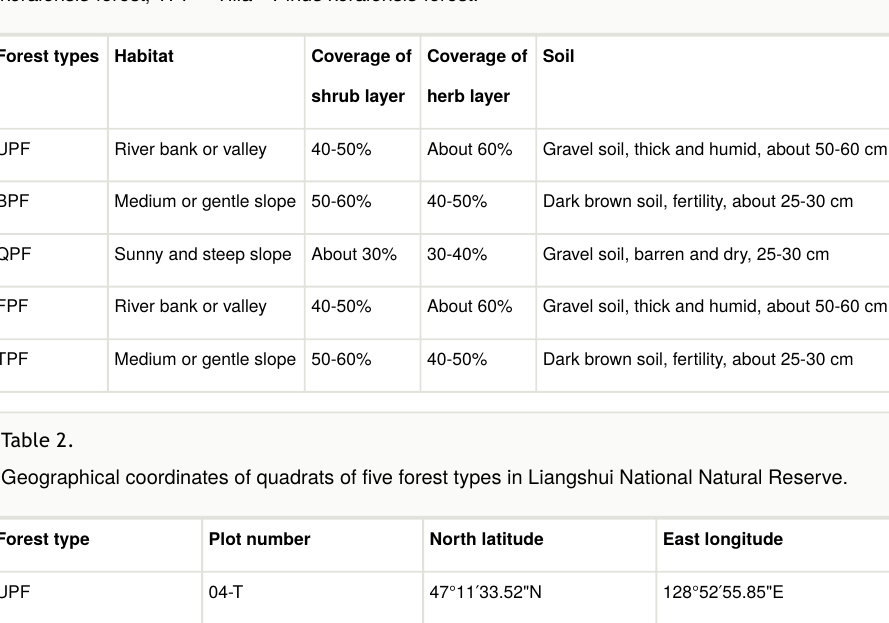
Basic description of fi ve forest types in Liangshui National Natural Reserve, where: UPF = Ulmus